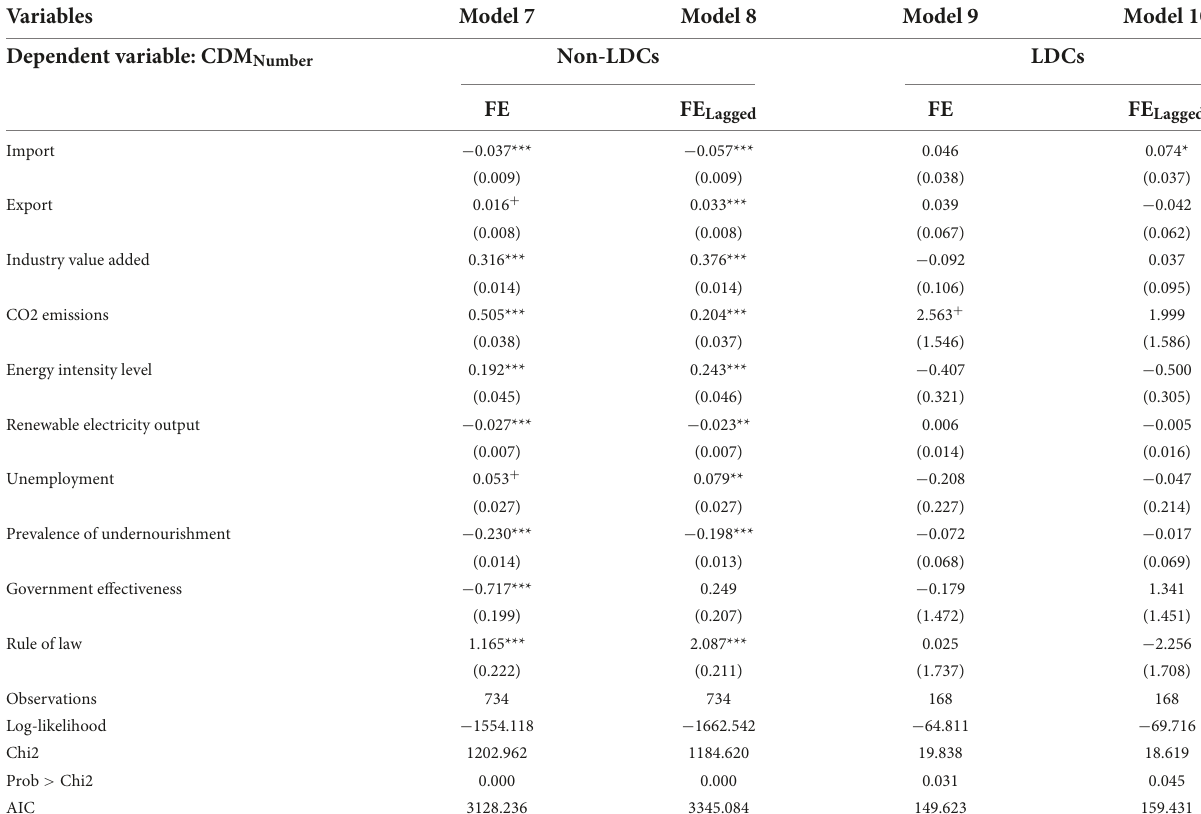
TABLE 7 Panel Poisson regression results with